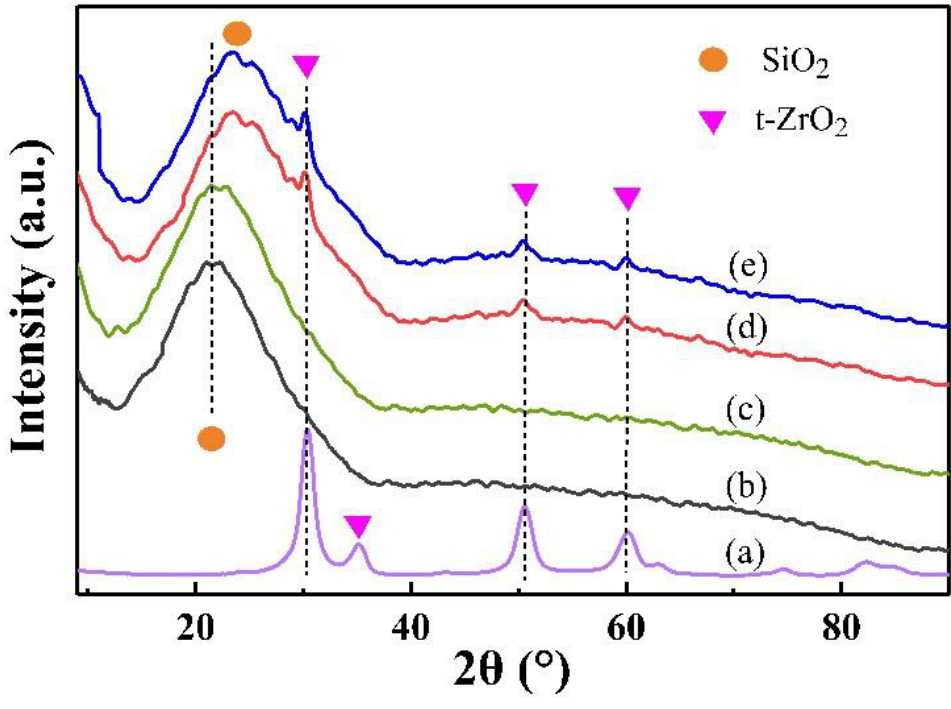
Figure 3. XRD pattern of ( a ) ZrO 2 , ( b ) hydrophilic SiO 2 , ( c ) hydrophobic SiO 2 , ( d ) hydrophilic ZrO 2 -SiO 2 , and ( e ) hydrophobic ZrO 2 -SiO 2 xerogels. Gels 2022 , 8 , 675